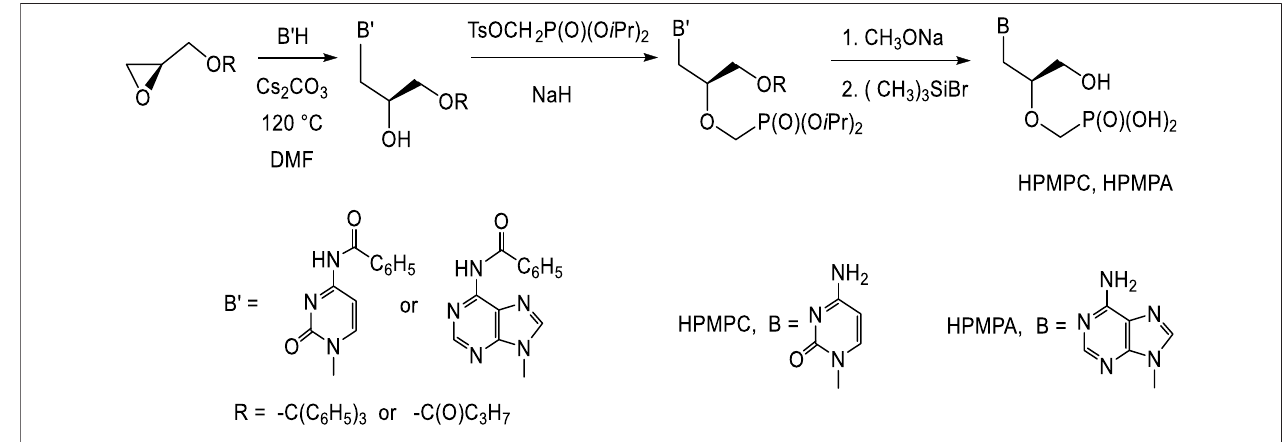
FIGURE 1 | Synthesis of ( S )-[3-hydroxy-2-(phosphonomethoxy)propyl] derivatives.